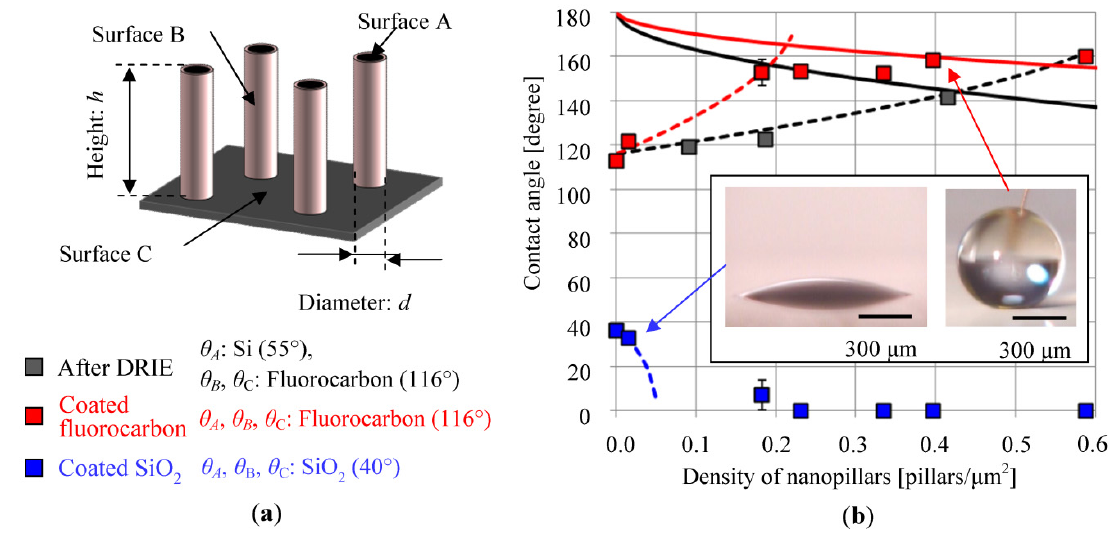
Figure 5. Evaluation of the contact angle: ( a ) analytical model of contact angle and ( b ) measured contact angle of water droplet as a function of the density of the nanopillars and the photographs of the droplet of the typical results.